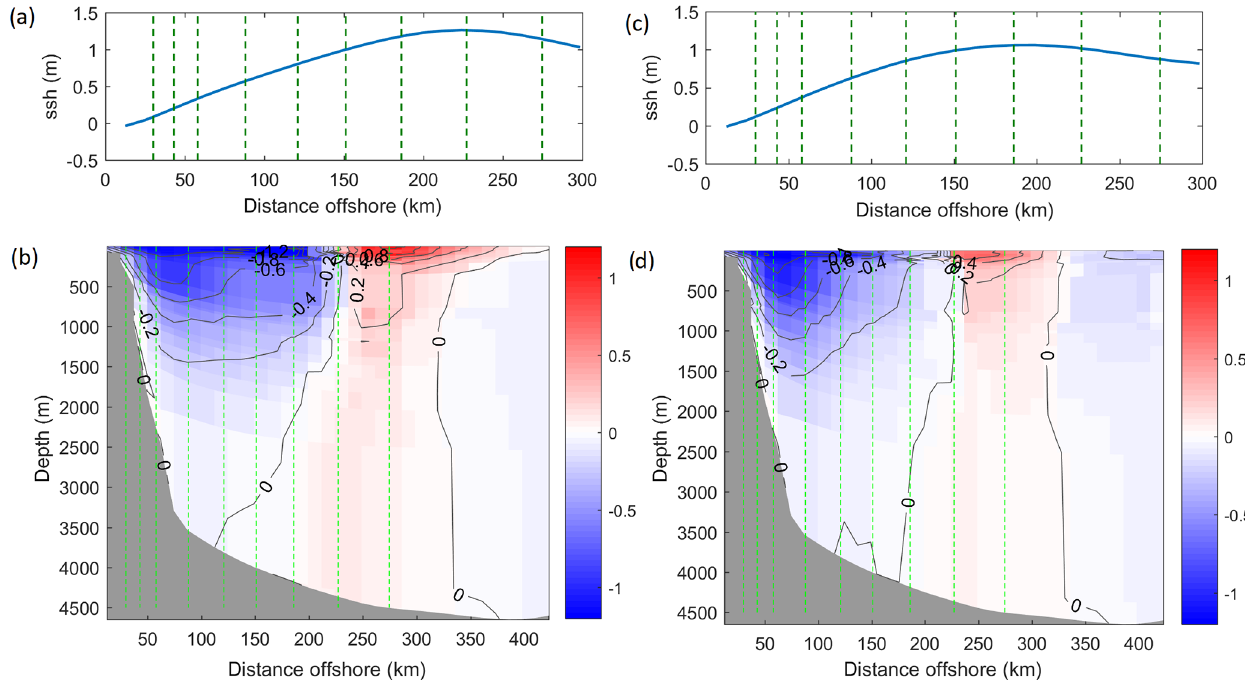
Figure 9. Mean SSH (metres, m) and composite cross-track velocity structure (metres per second, ms − 1 ) of the residual transport events from RM 8 (a, b) and RM 1 (c, d) . Blue shading represents the negative, southwest current flow and red represents the positive, northeast current flow. Contours are every 0.2ms − 1 . Dashed vertical lines represents the nine locations of the mooring and CPIES pairs, the first line representing mooring A and CPIES pair P4P5 furthest